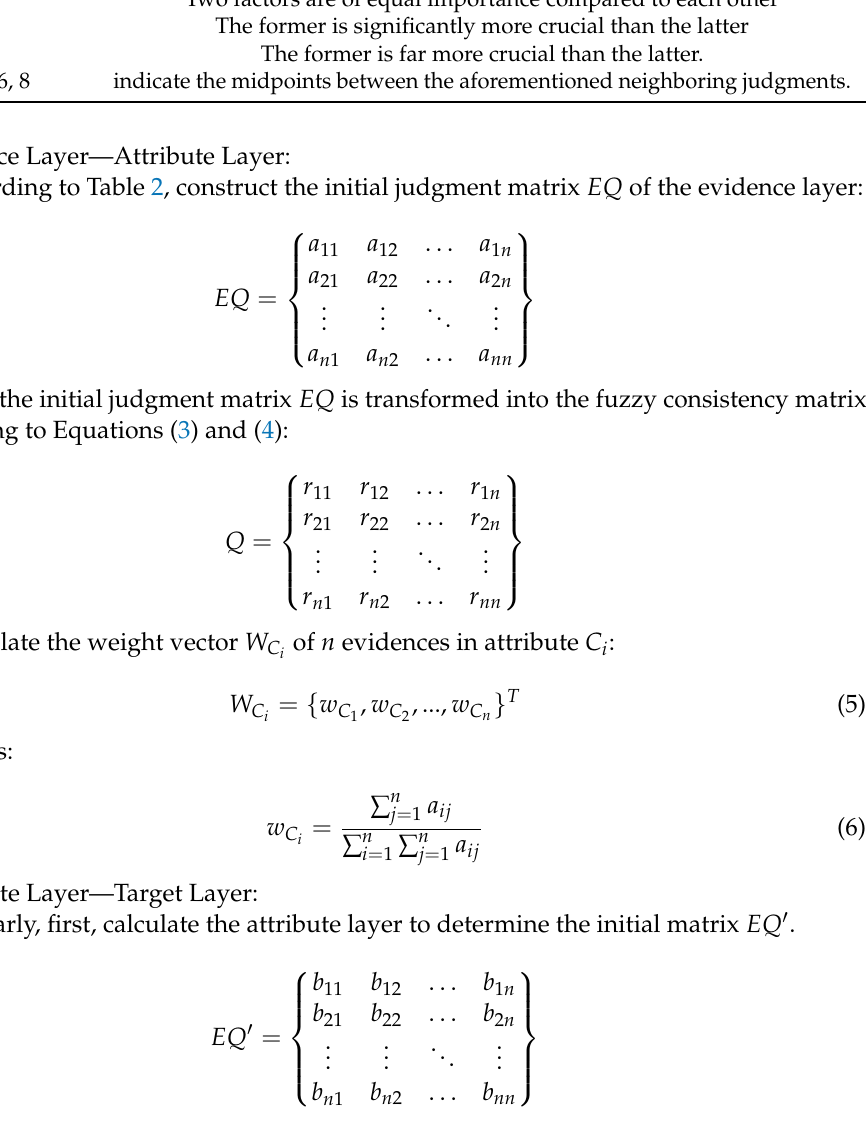
Table 2. Scale values. Scale Meaning 1 The former is extremely less important than the latter 3 The former is slightly less important than the latter 5 Two factors are of equal importance compared to each other 7 The former is significantly more crucial than the latter 9 The former is far more crucial than the latter. 2, 4, 6, 8 indicate the midpoints between the aforementioned neighboring